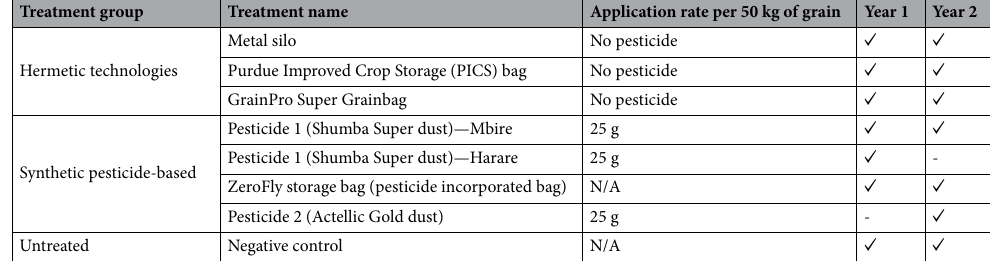
Table 1. List of treatments used in Ward 8 and 15 of Mbire district, Zimbabwe during the sorghum storage trials in the 2014/15 (Year 1) and 2015/16 (Year 2) storage seasons. ‘–’ indicates treatment not included in that year; N/A = not applicable. Shumba Super dust = fenitrothion 1% + deltamethrin 0.13%; Actellic Gold dust = pirimiphos-methyl 0.16% + thiamethoxam 0.036%; ZeroFly storage bag = deltamethrin-incorporated polypropylene bag at 3